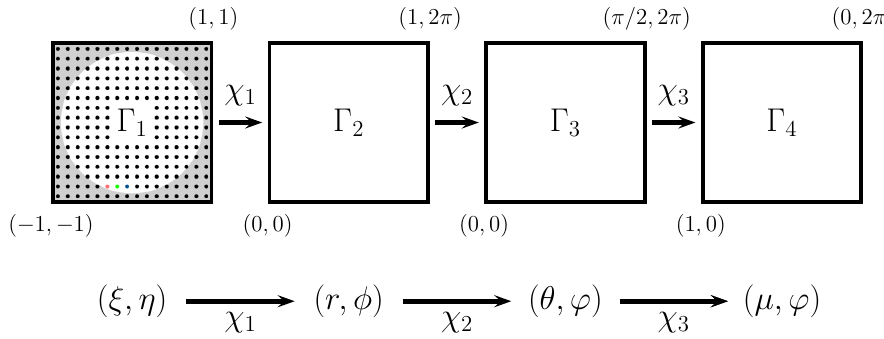
Figure 2. The mappings to transform the coordinates from the original Cartesian set (cid:9) Γ = (cid:8) ( ξ , η ) ξ 2 + η 2 < 1 to the target set Γ 3 = 1 |